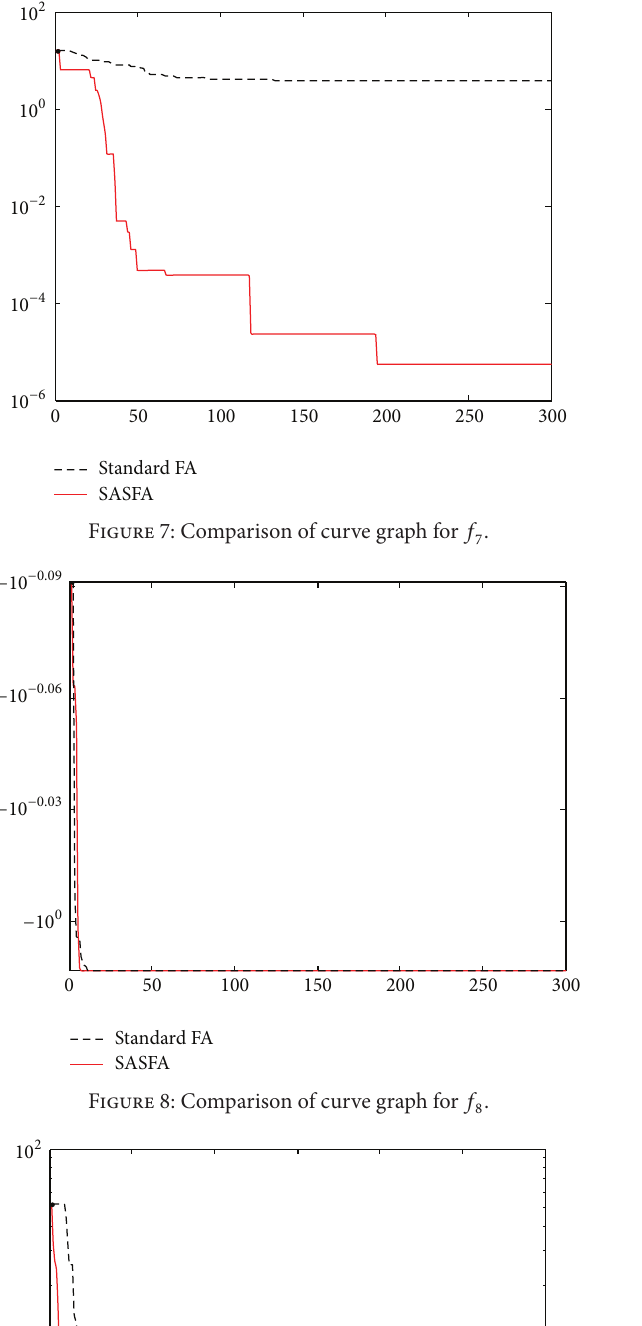
Figure 11: Comparison of curve graph for 𝑓 11 .